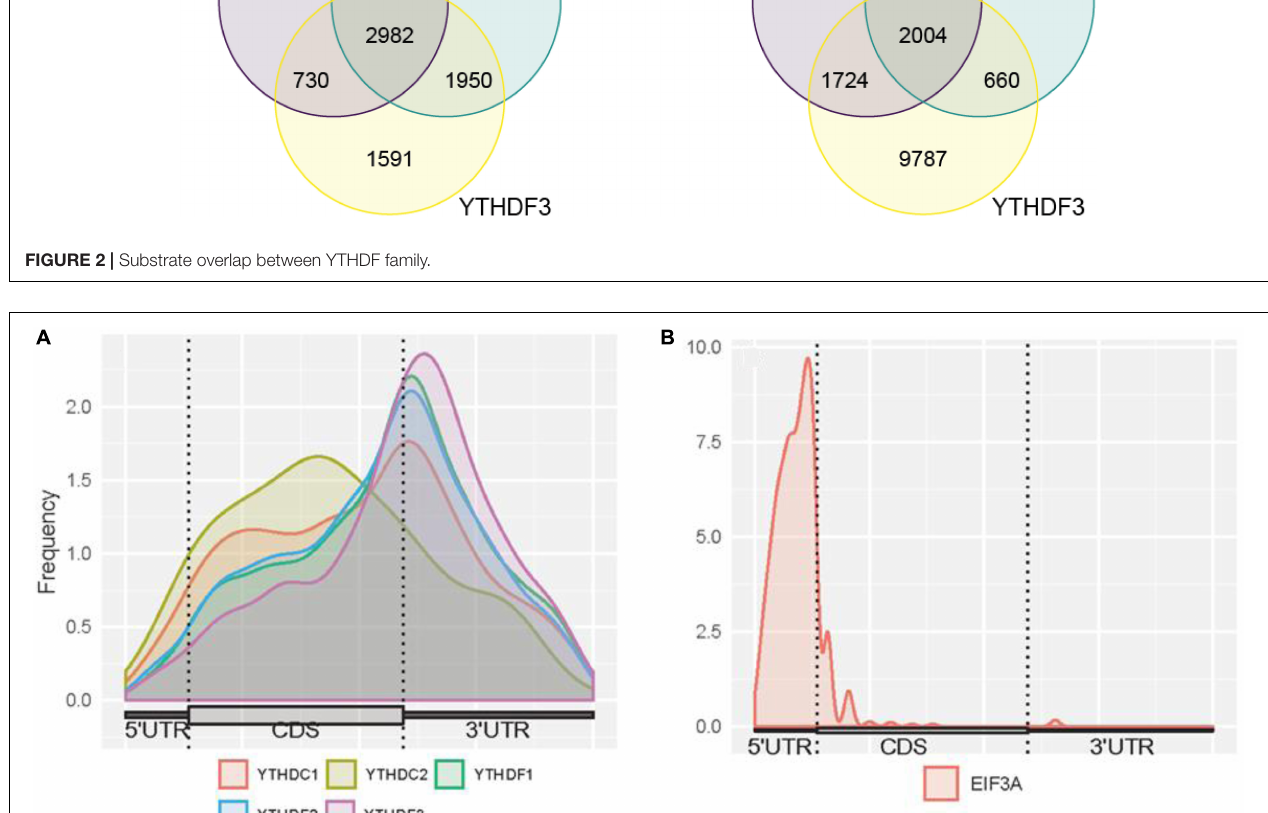
FIGURE 3 | Distribution of m 6 A readers binding sites on mRNAs. (A) Distribution of the binding sites of YTHDC1, YTHDC2, YTHDF1, YTHDF2, and YTHDF3 on mRNAs. (B) Distribution of the binding sites of EIF3A on mRNAs. The figures were plotted using the Guitar R/Bioconductor package (Cui et al., 2016).